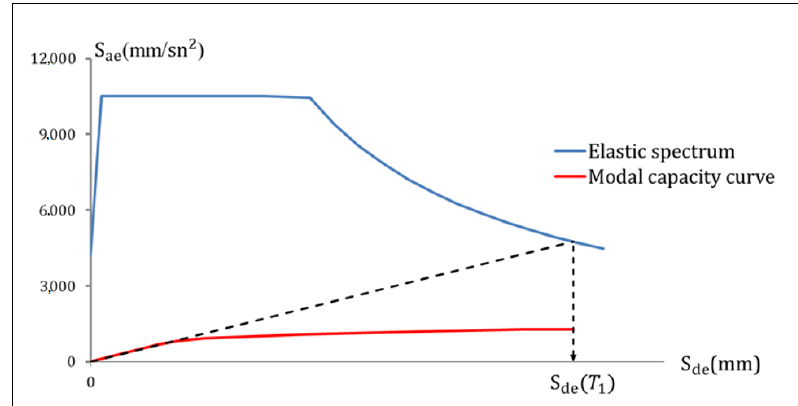
Figure 12. Obtaining the roof displacement demand for the reference model building.